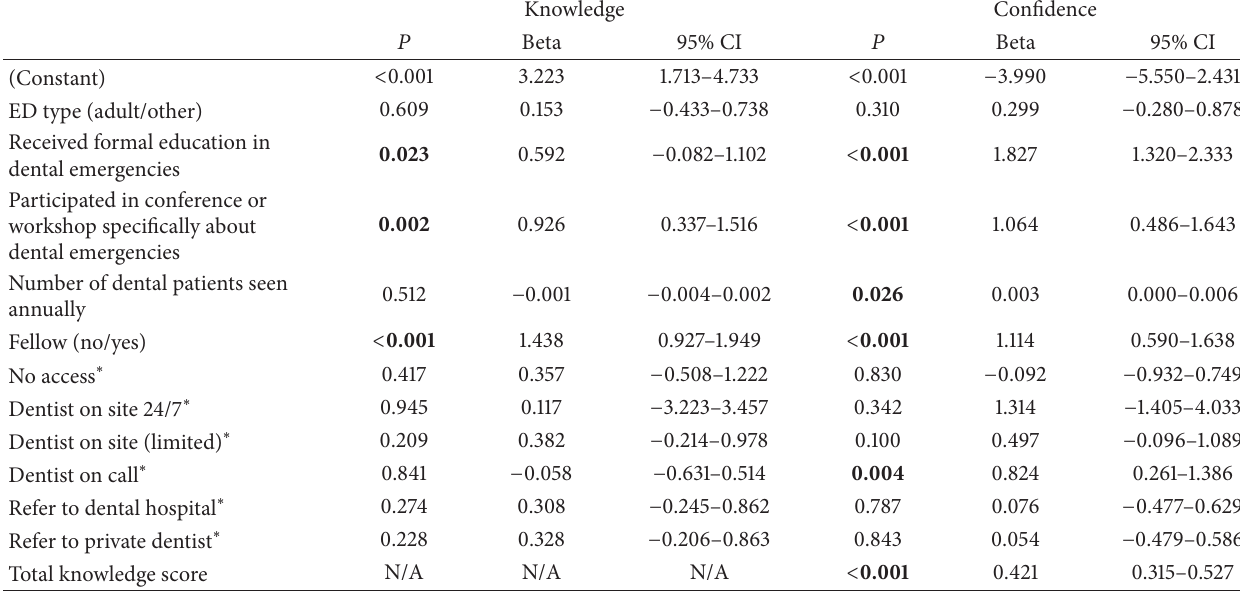
Table 4: Predictors of knowledge and confidence in dental